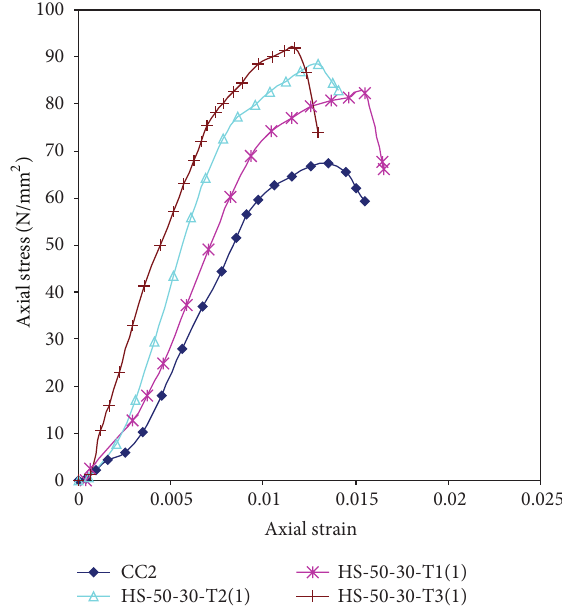
Figure 13: Axial stress-strain behaviour of columns